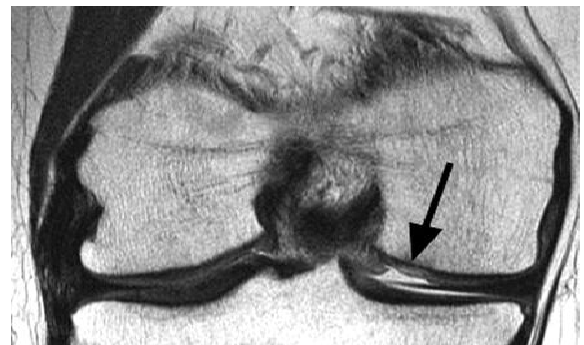
Fig 1: MRI picture of femoral condylar cartilaginous